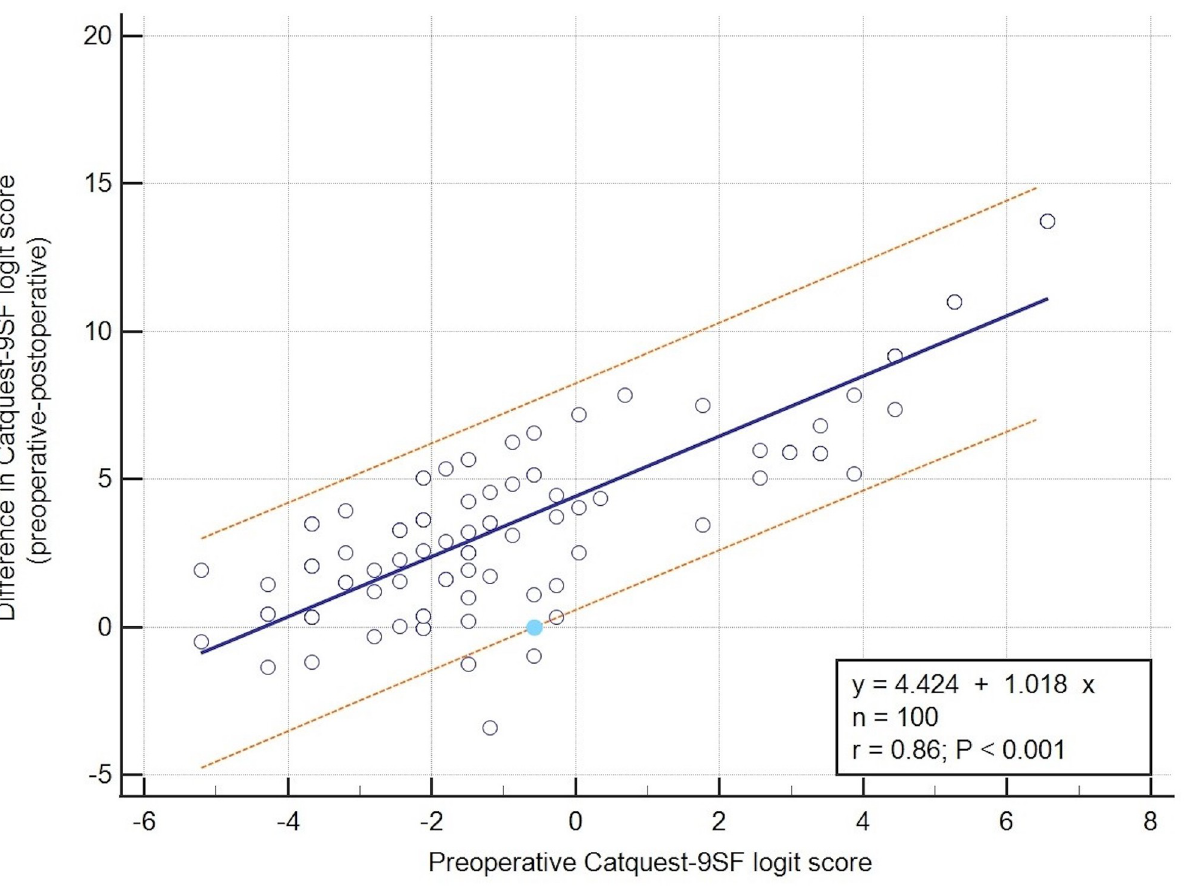
Fig 3. Correlation analysis with 95% prediction interval of the preoperative Catquest-9SF logit score with the difference between the preoperative and the postoperative Catquest-9SF logit score. Line is mean, dotted lines are 95% prediction interval. The blue dot corresponds to the value -0.55.